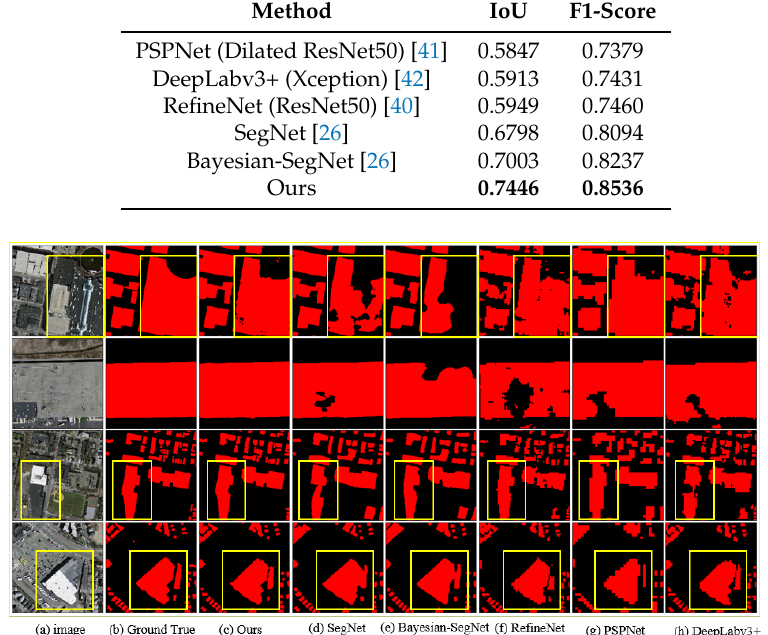
Figure 7. Typical results of our method and five other state-of-the-art methods: ( a ) Input image; ( b ) ground truth; ( c ) the result of our method BRRNet; ( d ) the result of SegNet; ( e ) the result of Bayesian-SegNet; ( f ) the result of RefineNet; ( g ) the result of PSPNet; and ( h ) the result of DeepLabv3+. The areas in the yellow boxes are the more obvious